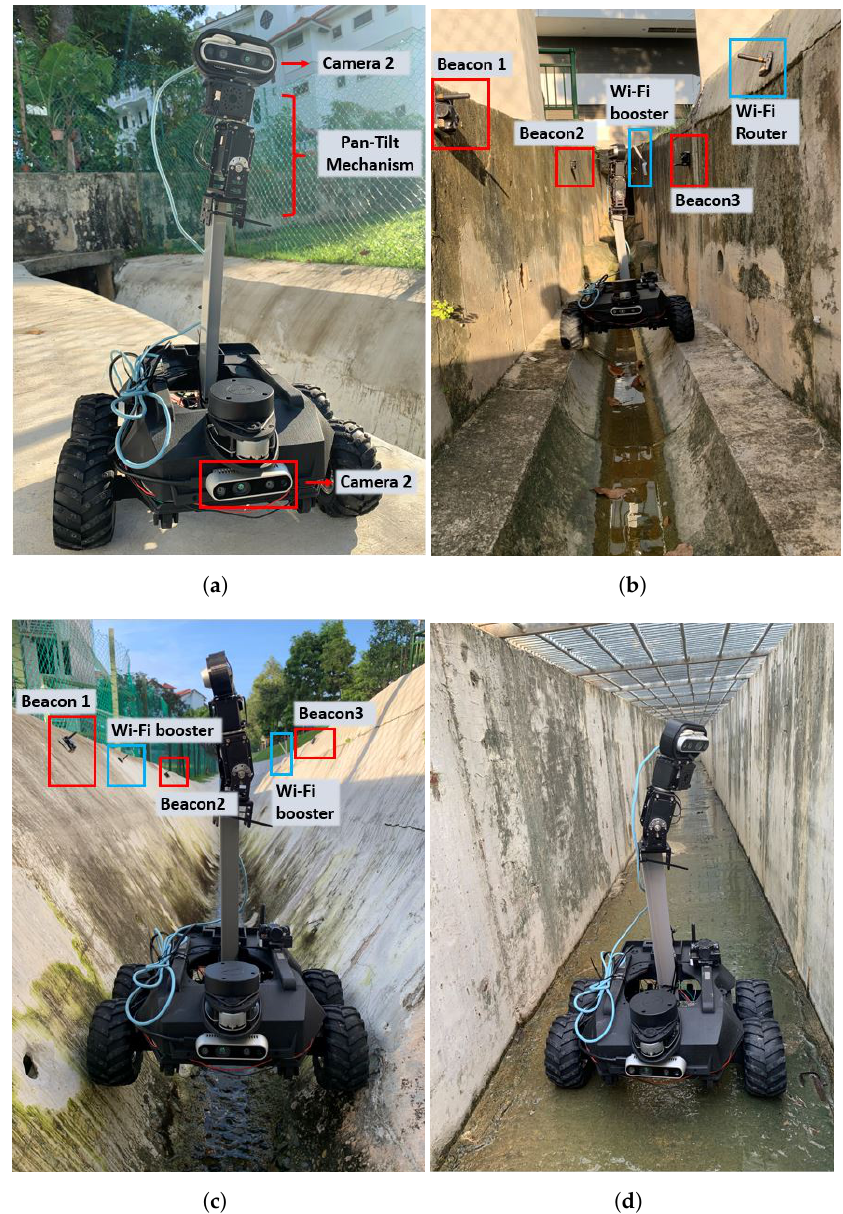
Figure 16. Raptor robot field experiments and defect detection in different drain types. ( a ) Robot and Pan-tilt mechanism; ( b ) Type S2 drain; ( c ) Type C7 drain; ( d ) Flat